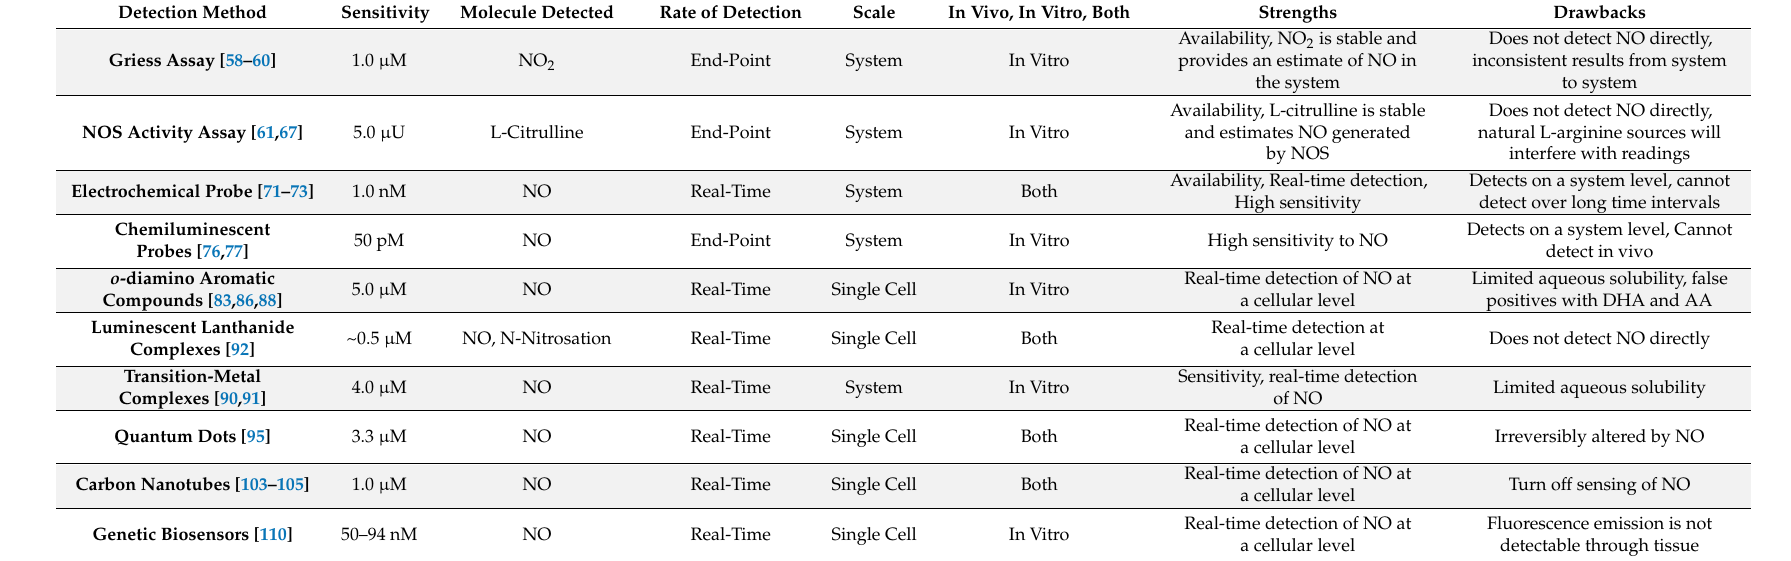
Table 1. Overview of the nitric oxide (NO) sensing methods discussed in this review with the assay/instruments’ molecule and rate of detection, sensitivity, scale, strengths and current drawbacks